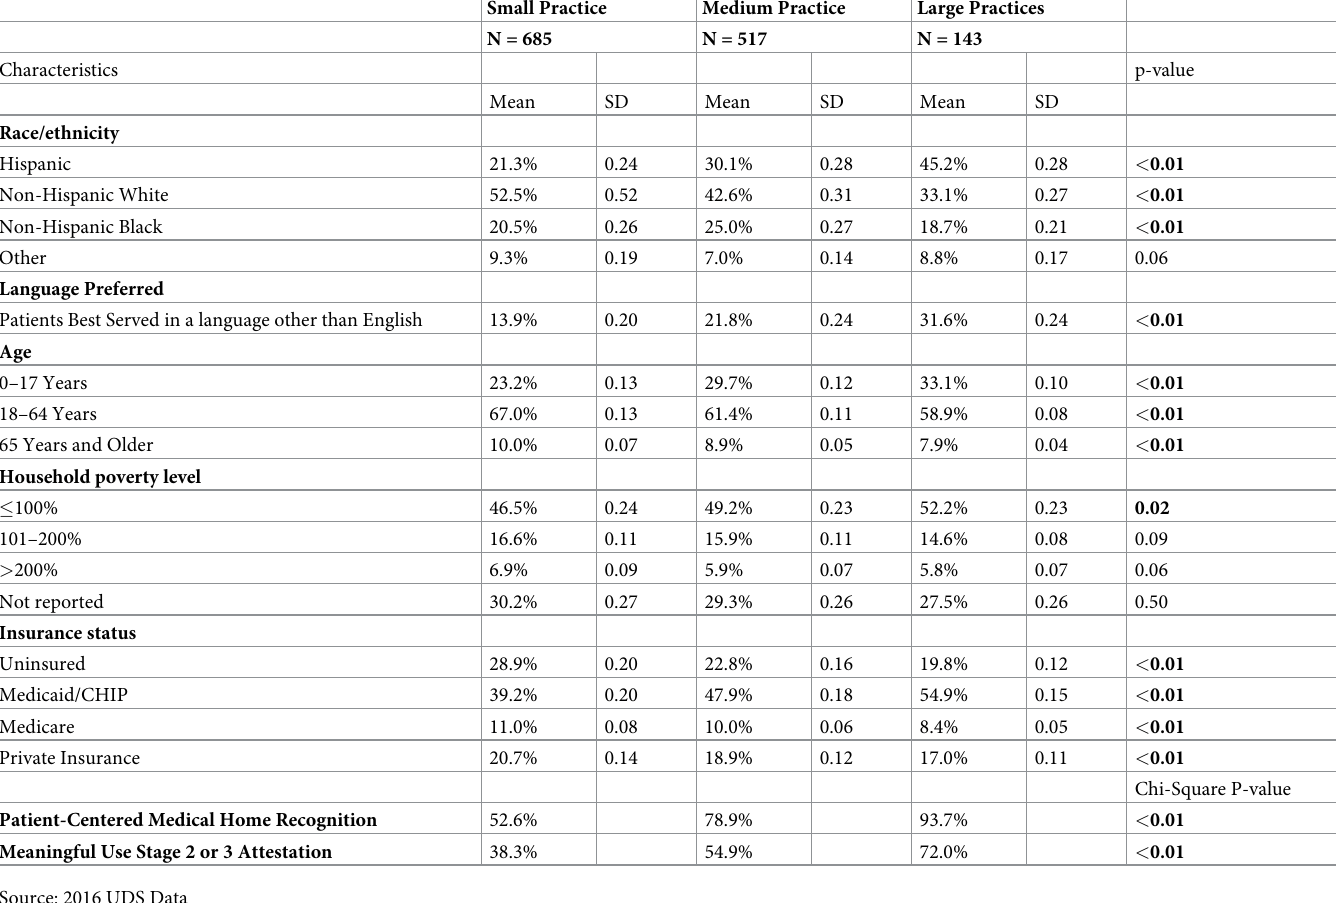
Table 1. Characteristics of Health Centers (HC) and patients served by practice